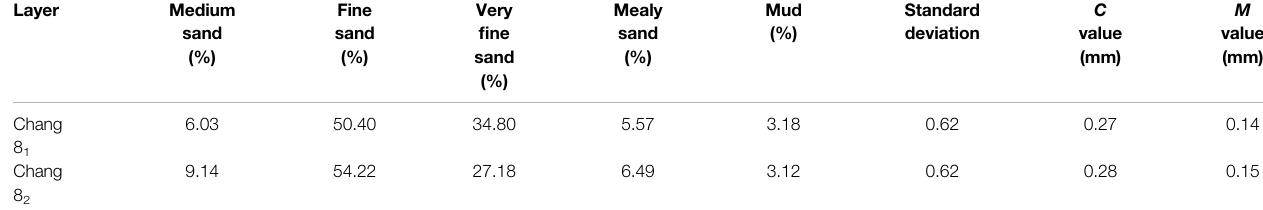
TABLE 5 | Sandstone grain size of Chang 8 reservoir in Wuqi – Zhijing – Ansai area. Layer Medium sand